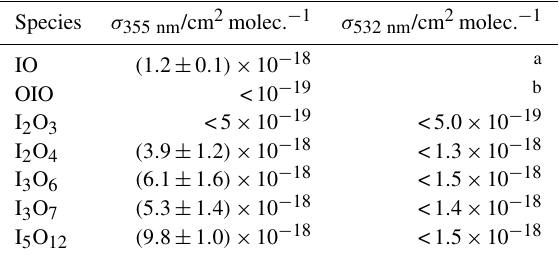
Table 1. Absorption cross sections of iodine oxides at 532 and